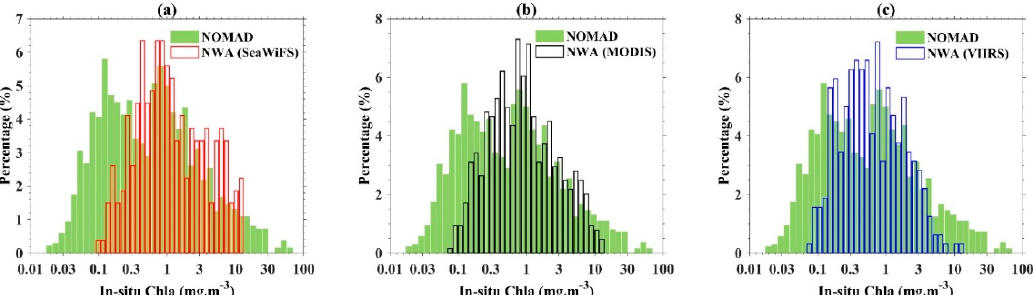
Figure 3. Frequency distribution of in situ Chl a for matched ( a ) SeaWiFS, ( b ) MODIS, and ( c ) VIIRS, respectively. Frequency distribution of Chl a for NOMAD dataset is also presented for reference.